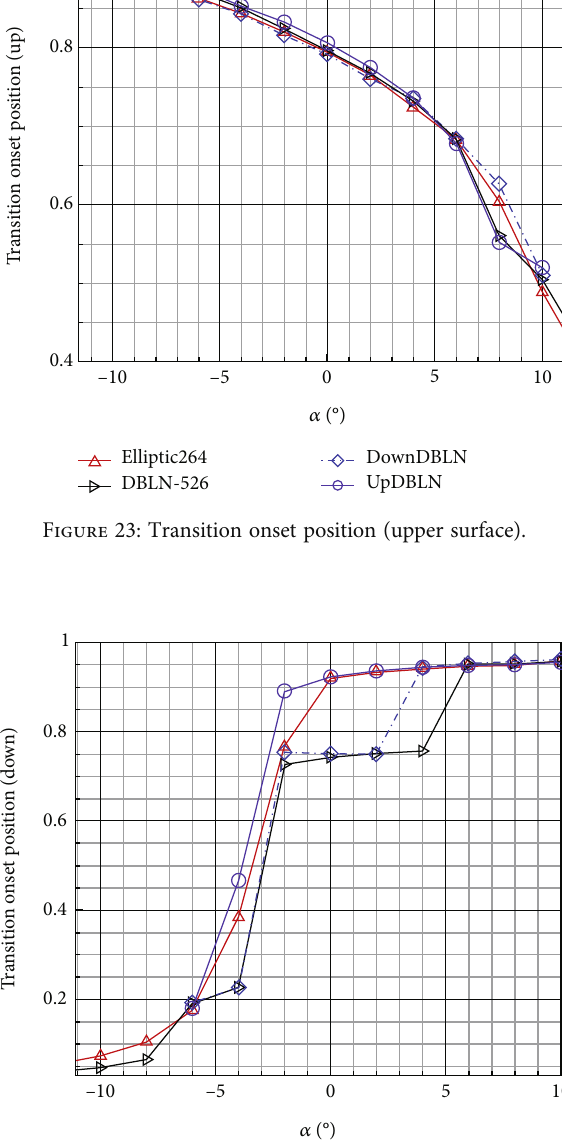
Re = 0 : 8 E 6 , α = 0 ° Figure 26: λ θ distribution for DBLN (